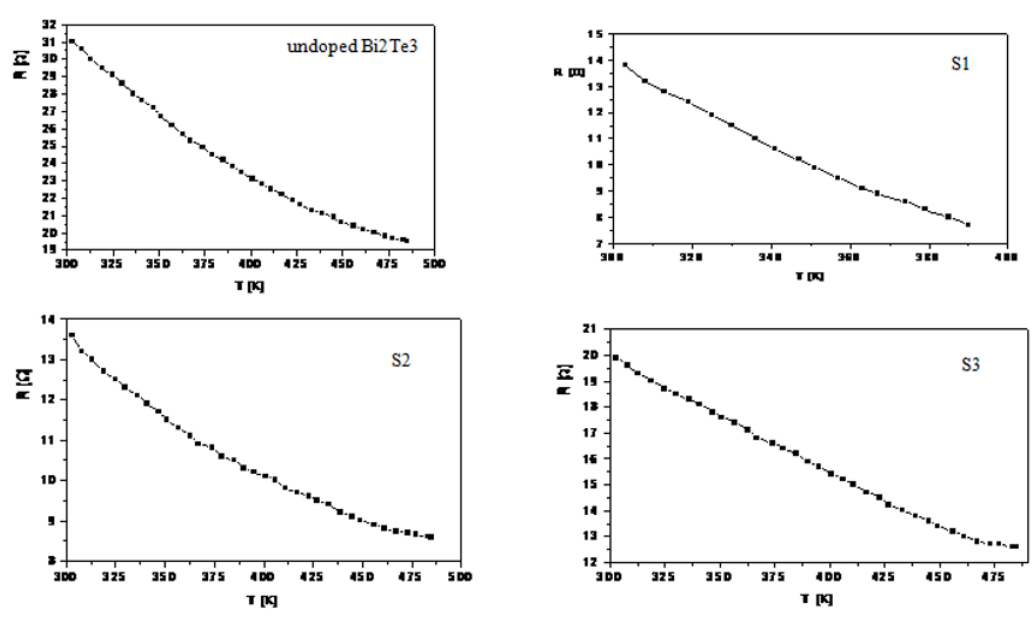
Figure 4. Temperature dependence of the electrical resistivity of undoped and doped Bi